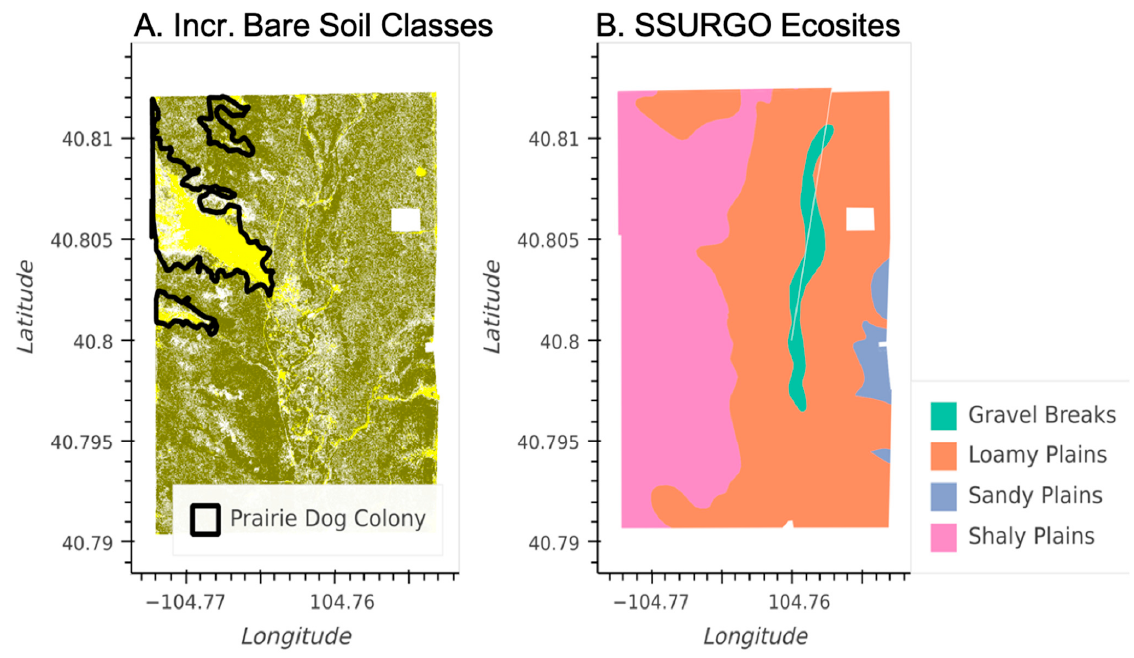
Figure 9. Maps of a pasture at CPER (see Figure 1) with extensive prairie dog colonies. ( A ) 2013 NEON plant community classification map showing regions with elevated bare soil (yellow), regions with more continuous vegetation cover (olive), and boundaries indicating regions that had active prairie dog colonies during both 2012 and 2013 based on detailed in situ (field ‐ based) mapping (black polygons). ( B ) SSURGO Ecosite map of the same pasture.